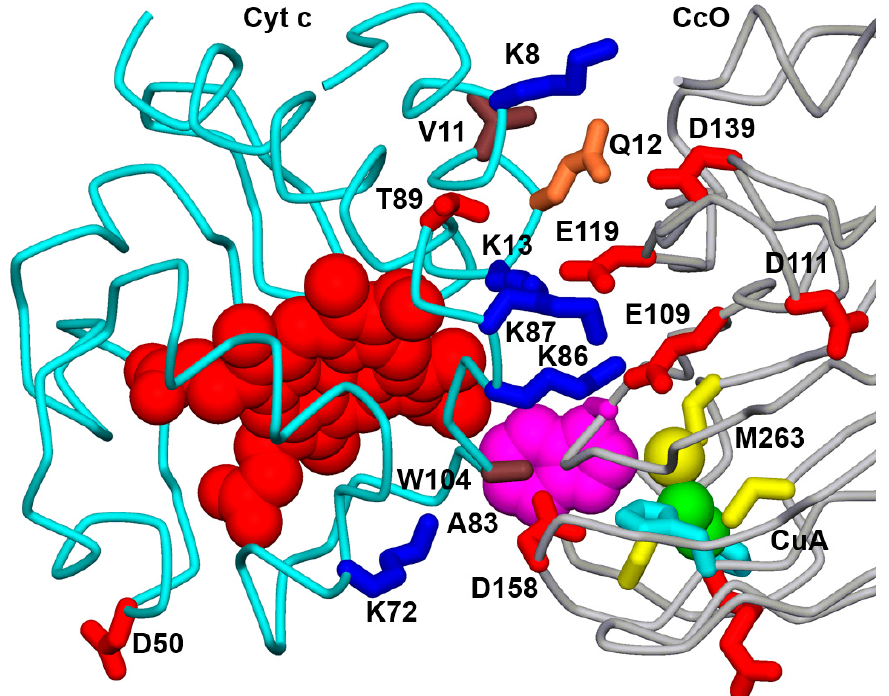
Figure 3. Structure of the computational horse Cc:CcO complex [52] showing the amino acid residues that are mutated from horse to human Cc. Cc lysines and CcO aspartates and glutamates are also shown.